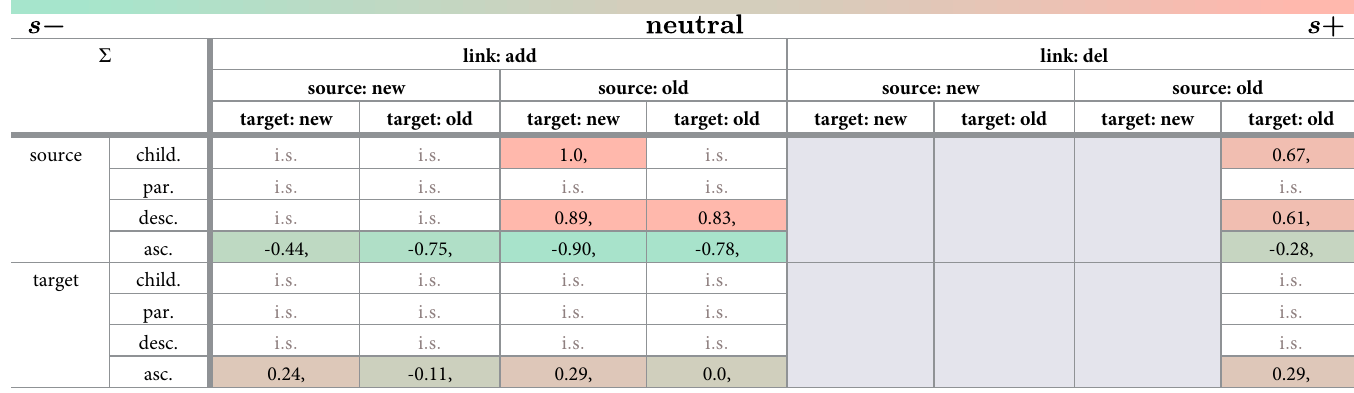
Table 3. Aggregated summary results. Based on Table 2. and Tables H-N in S1 Text, the contribution to a given cell is counted according to ‘s+’ = 1, ‘w+’ = ’p+’ = 0.5, ‘s0 = 0’, ‘w–’ = ’p–’ = -0.5, ‘s–’ = -1, and the obtained sum is divided by the number of tables contributing to the given cell. Aggregated cells become ‘i.s’ if more than 3 out of the 7 tables has ‘i.s.’ as